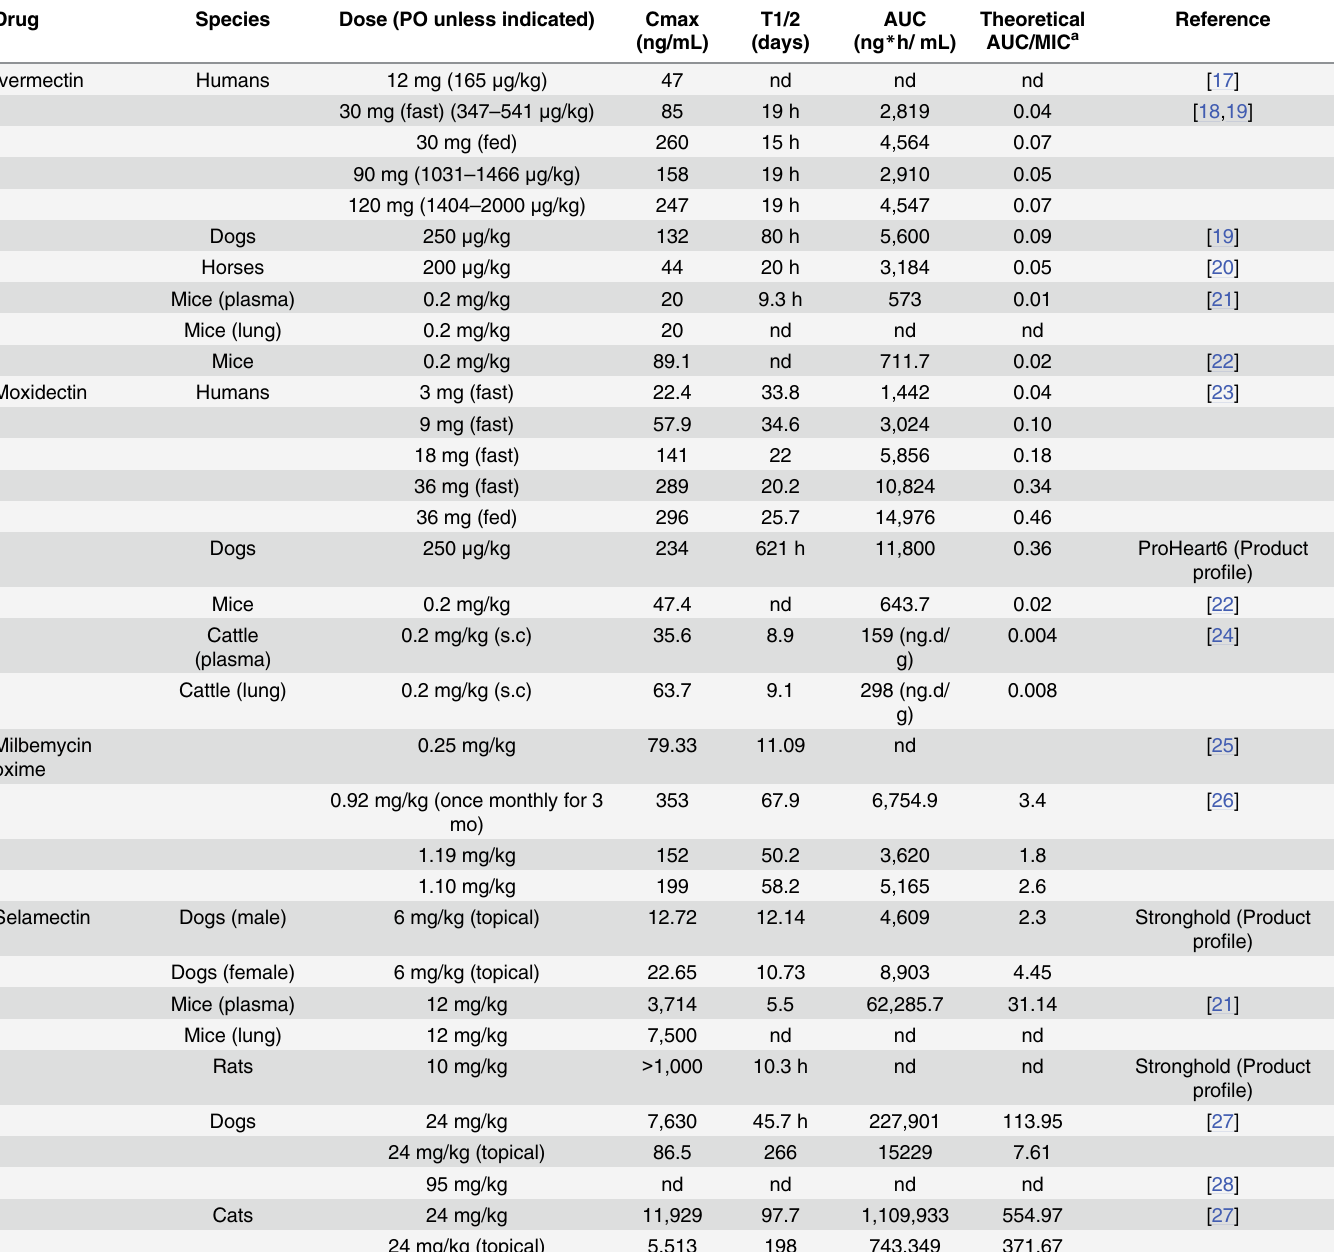
Table 2. Pharmacokinetic meta-analysis summary of selected avermectins and milbemycins.